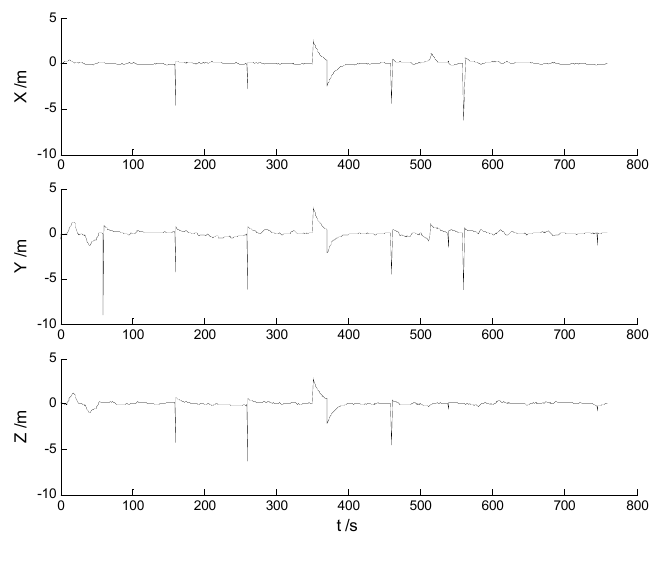
Figure 8. Position errors of the CKF algorithm.